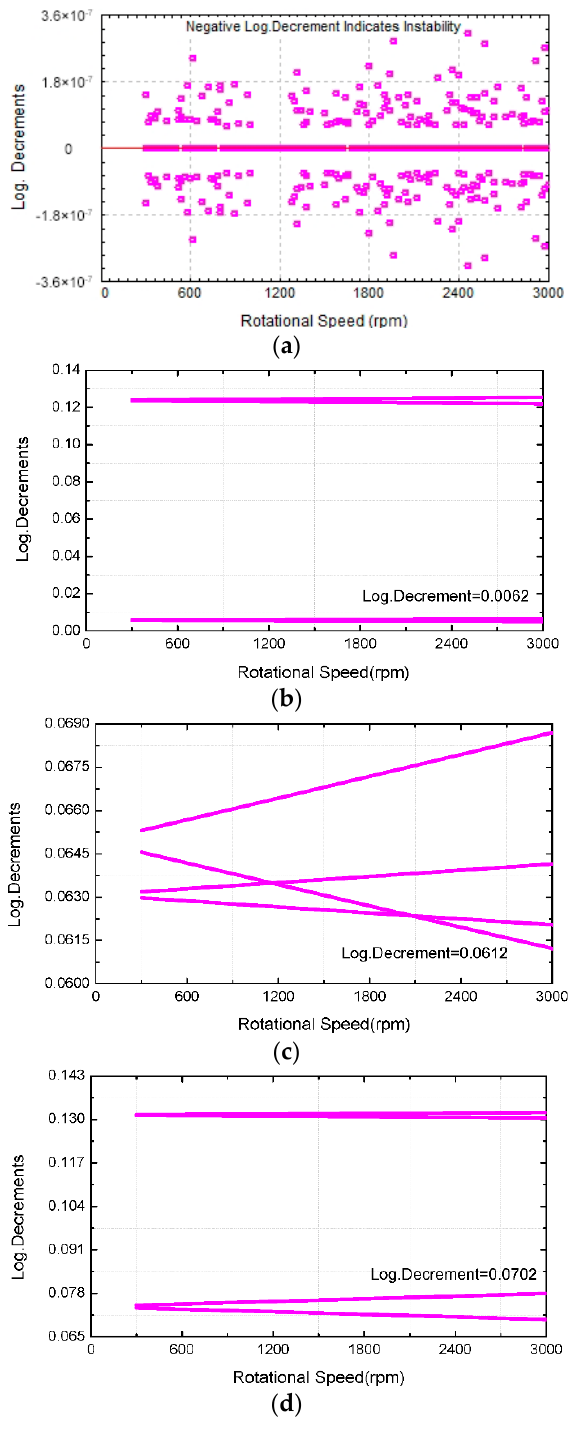
Figure 11. Stability of unbalanced single-side cantilevered rotor system: ( a ) working condition 1; ( b ) working condition 2; ( c ) working condition 3; ( d ) working condition 4.